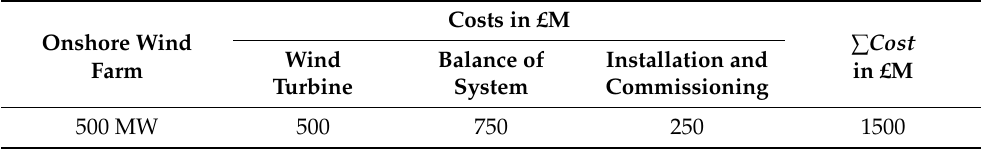
Table 8. Onshore wind-farm cost estimation.